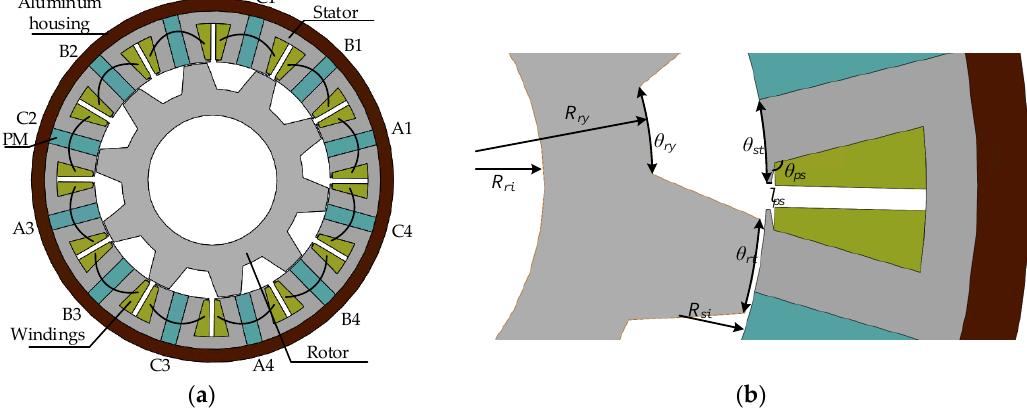
Figure 9. Prototype of 12/10 flux switching permanent magnet (FSPM) machine. ( a ) Sectional view. ( b ) Local diagram.